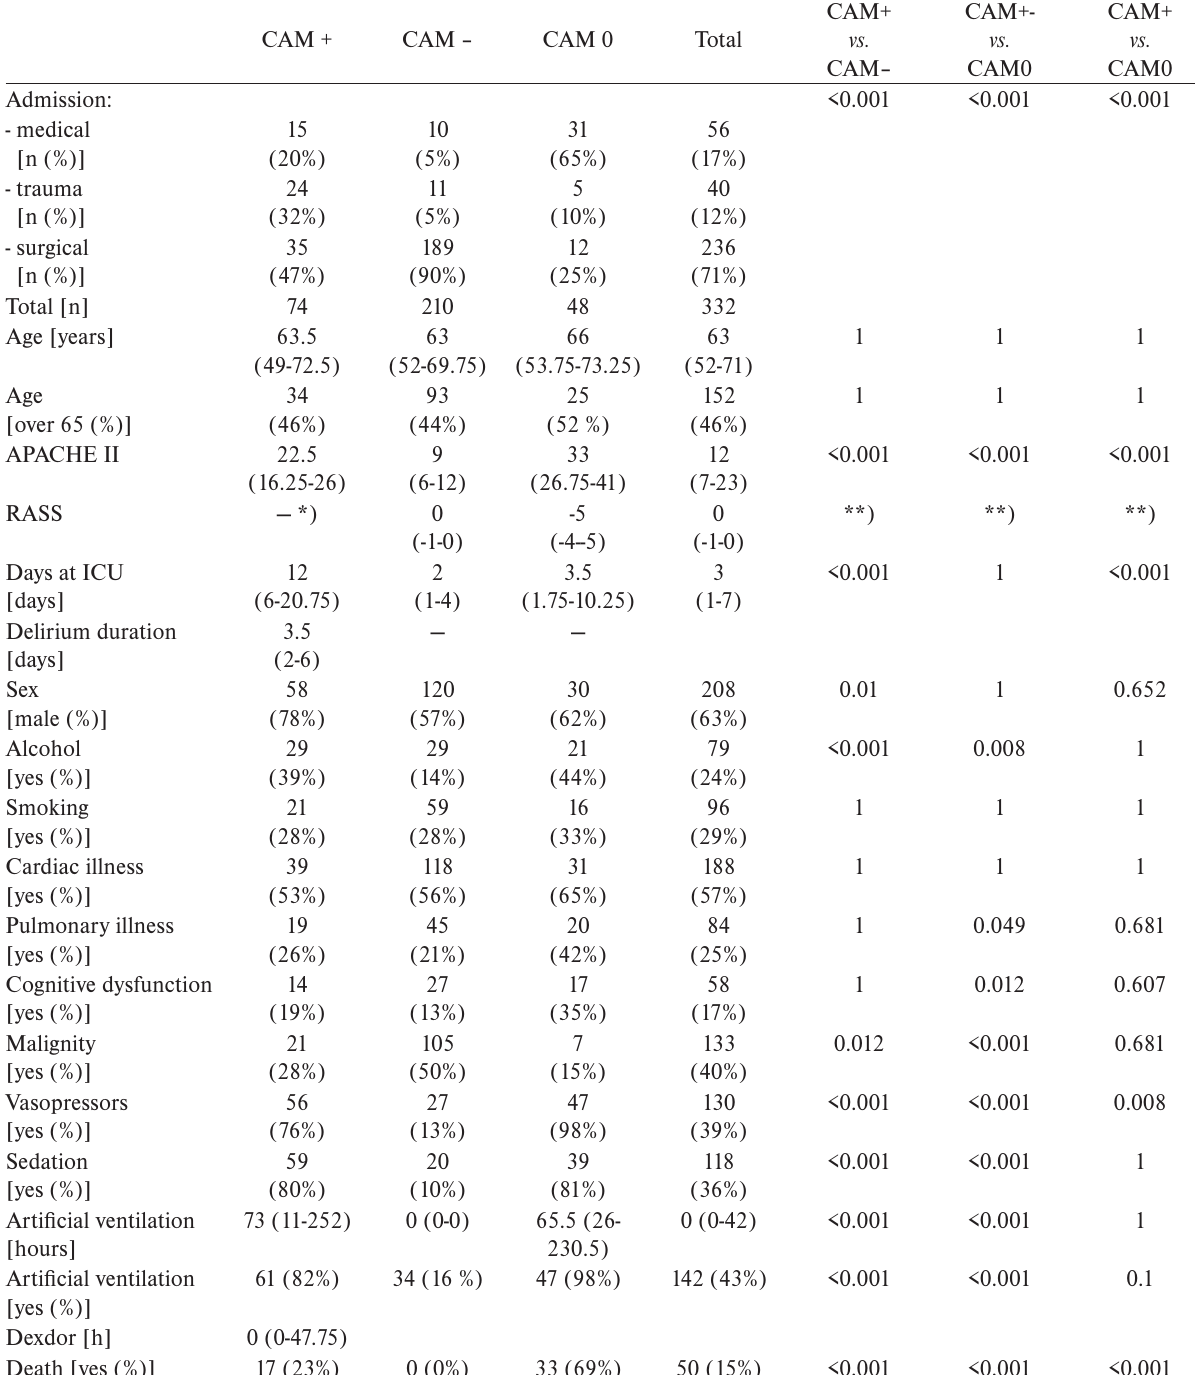
Table 2. Baseline characteristics of